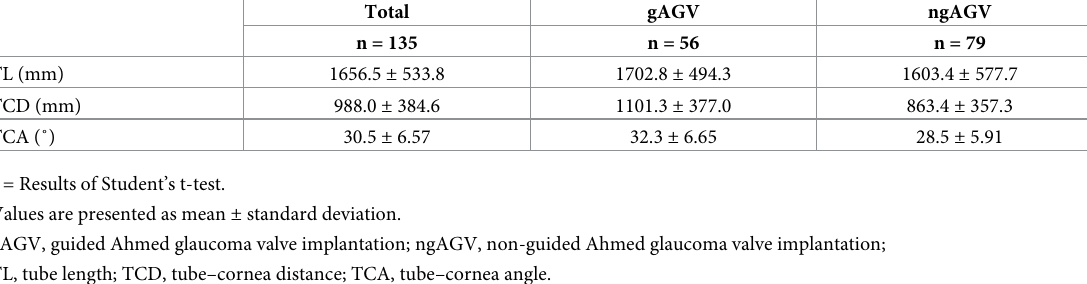
oxidative, apoptotic, and inflammatory proteins to enter the AC and alter the aqueous humor environment [21, 22]. In addition to tube-related factors, other factors can influence corneal ECD, including age, toxicity from glaucoma medication, high preoperative IOP, longer duration of high IOP before surgery, higher number of previous intraocular surgeries, and history of uveitis [23].